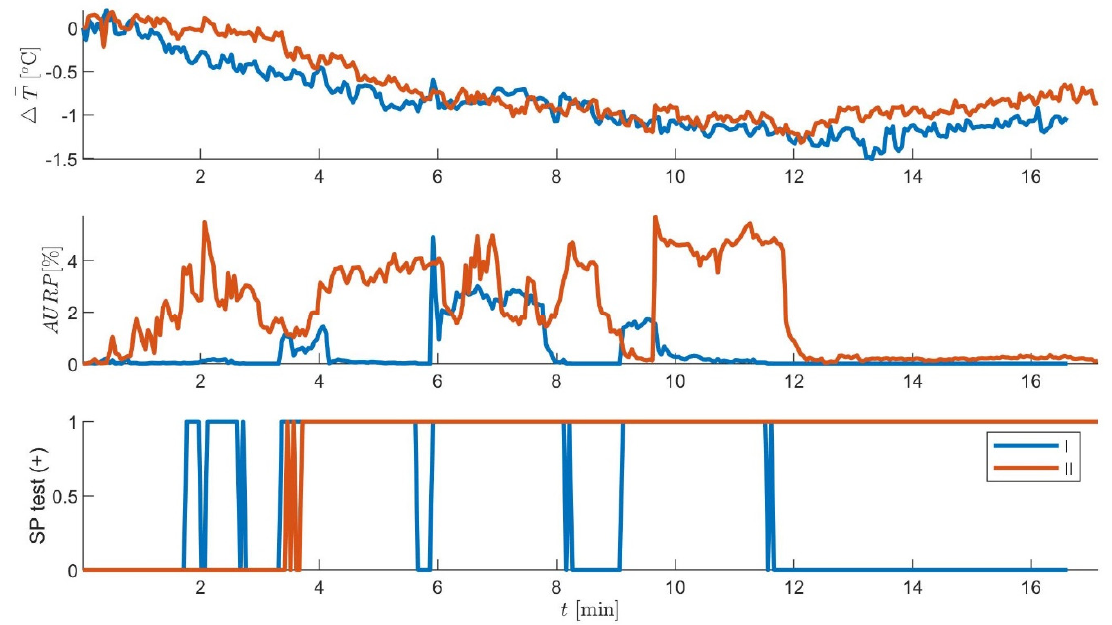
Figure 4. Detailed data of the two SP test diagnostic parameters and the number of positive vs. negative thermograms over time. Legend: ( a ) Development of the